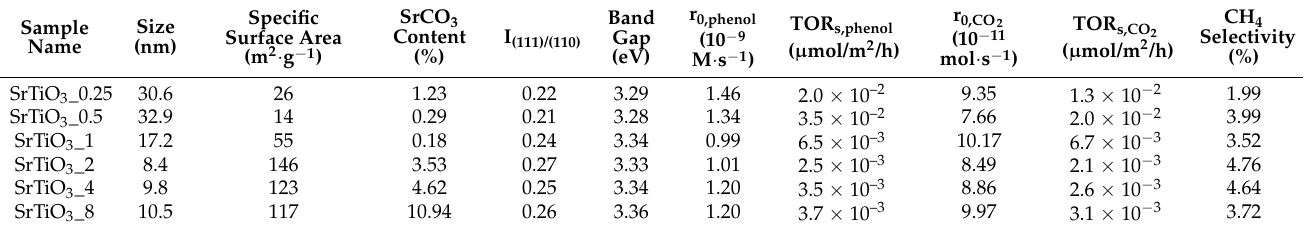
Table 1. Dependence of structural properties, optical properties, photocatalytic activity, and me-